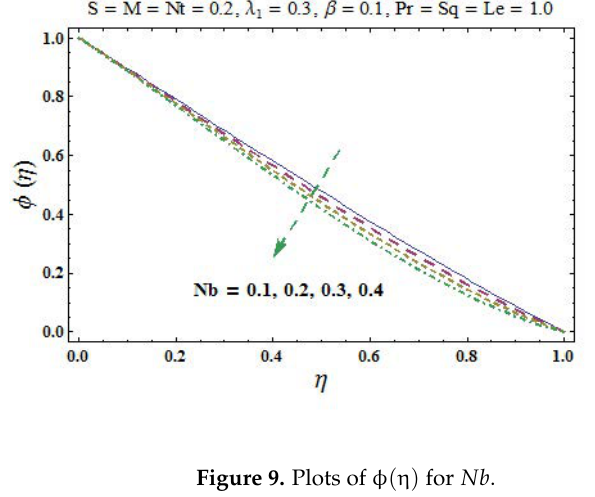
Figure 9. Plots of φ ( η ) for Nb .